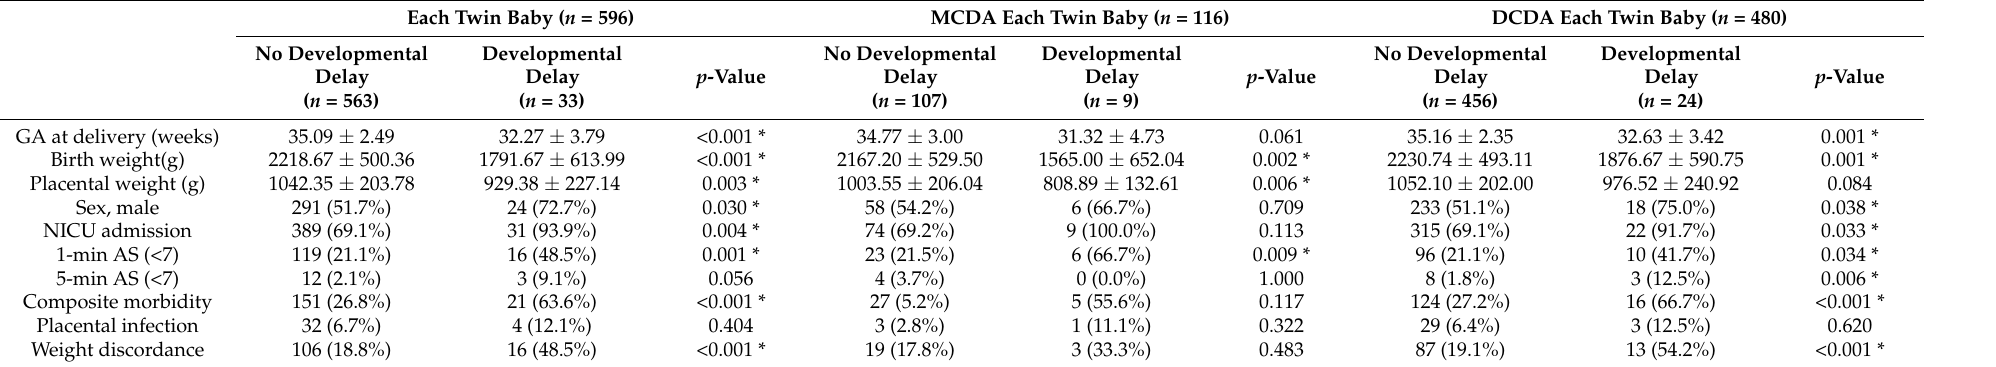
Table 4. Neonatal outcomes in relation to neurodevelopmental delay according to